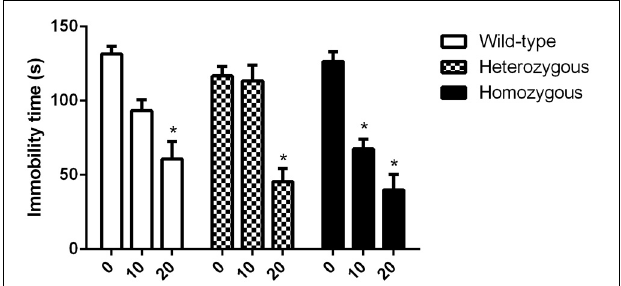
FIGURE 1 | Effect of imipramine on the immobility time of Wfs1-deficient mice in the TST. ∗ p < 0 . 01 compared to vehicle-treated mice of the same genotype (Scheffe post-hoc test after significant Two-Way ANOVA). Altogether, 70 wild-type, 67 heterozygousand 71 homozygous mice were used. Mice were randomly divided between respective study groups. Genotype [ F ( 2 , 199 ) = 4 . 2, p < 0 . 05]; treatment [ F ( 2 , 199 ) = 84 . 1, p < 0 . 01]; genotype × treatment [ F ( 4 , 199 ) = 3 . 5, p < 0 . 01].